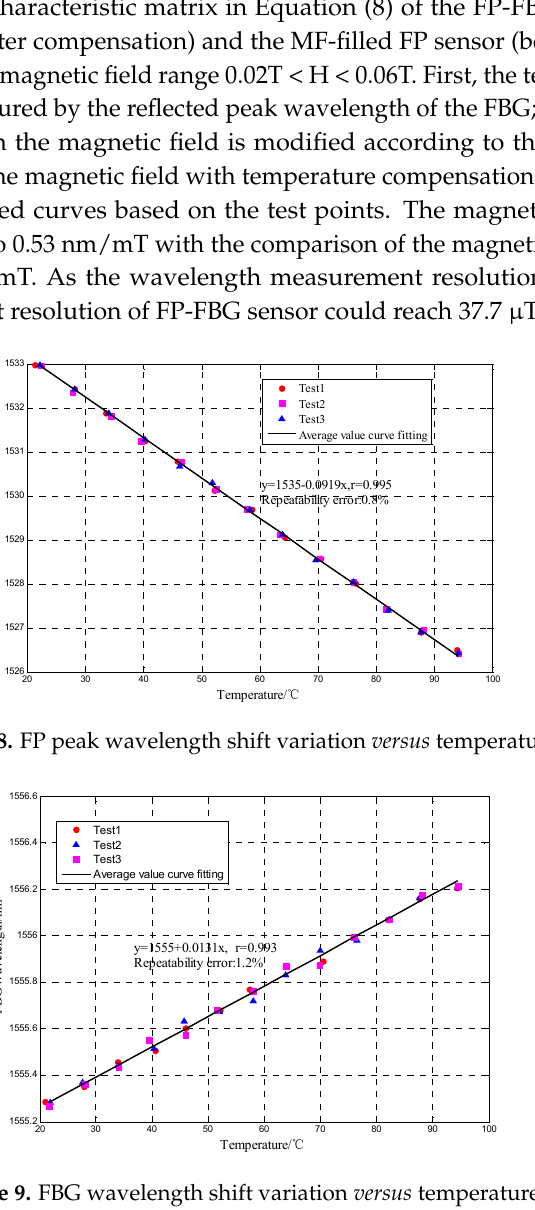
Figure 6. Spectrograms under a magnetic field range of 0~30 mT.